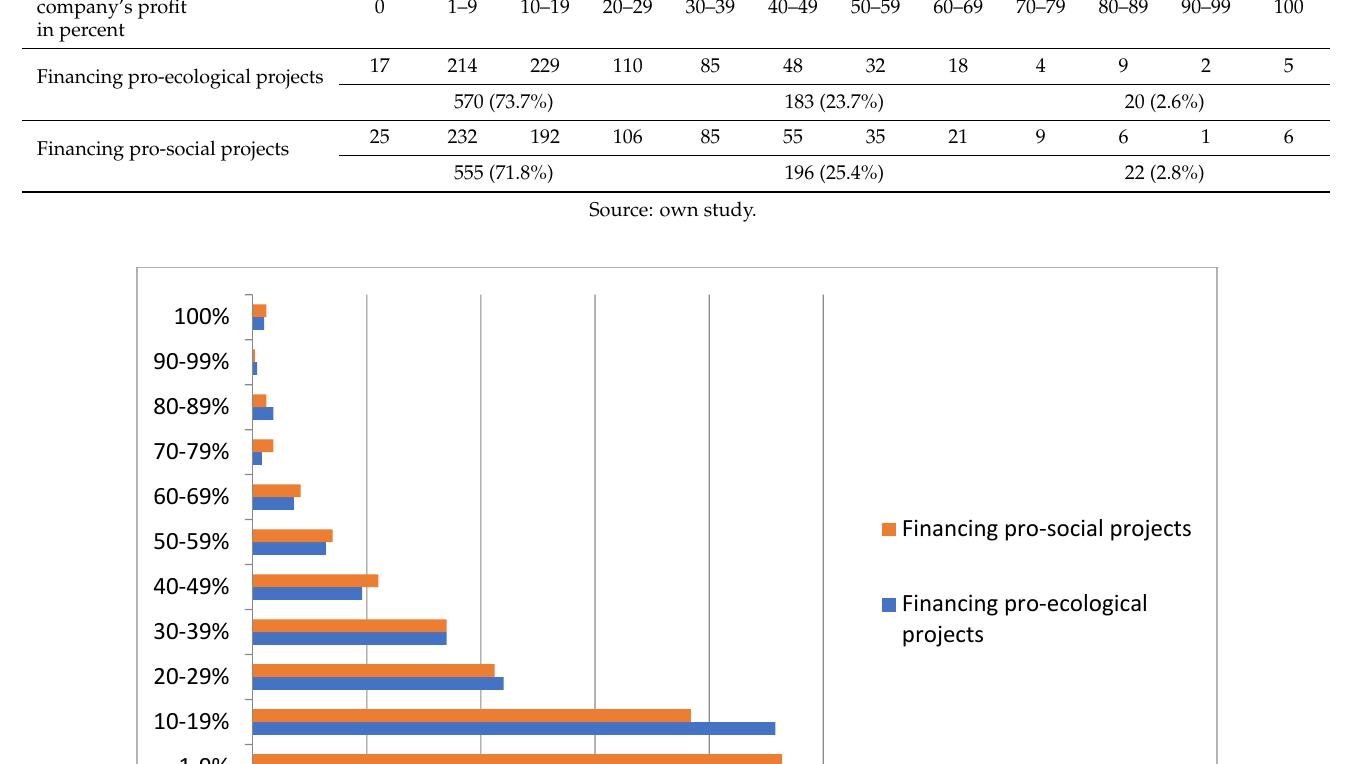
Table 2. Declarations on the financing of pro-ecological and pro-social projects in enterprises by the younger generation. Orientation Concerning Project Financing